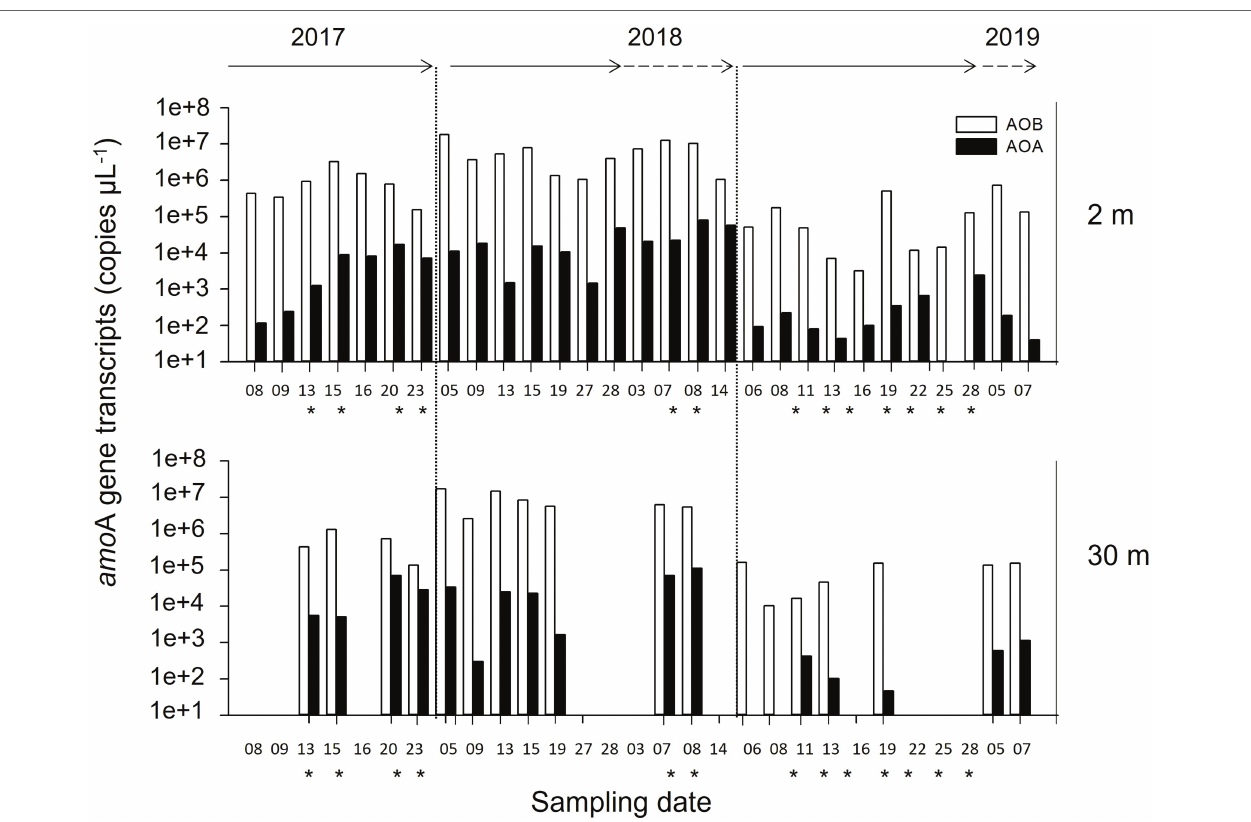
FIGURE 3 | Abundance and inter-seasonal dynamics of amo A transcripts for ammonia-oxidizing archaea (AOA) and bacteria (AOB) recorded at 2 and 30 m depth in Chile Bay over three late-summer periods (February to early March of 2017, 2018, and 2019). White and black bars represents the number of amo A transcripts for AOB and AOA, respectively. The lack of bars at 30 m means the loss of samples at that depth. *Represents stratified water column events and solid and dotted arrows represent February and March,